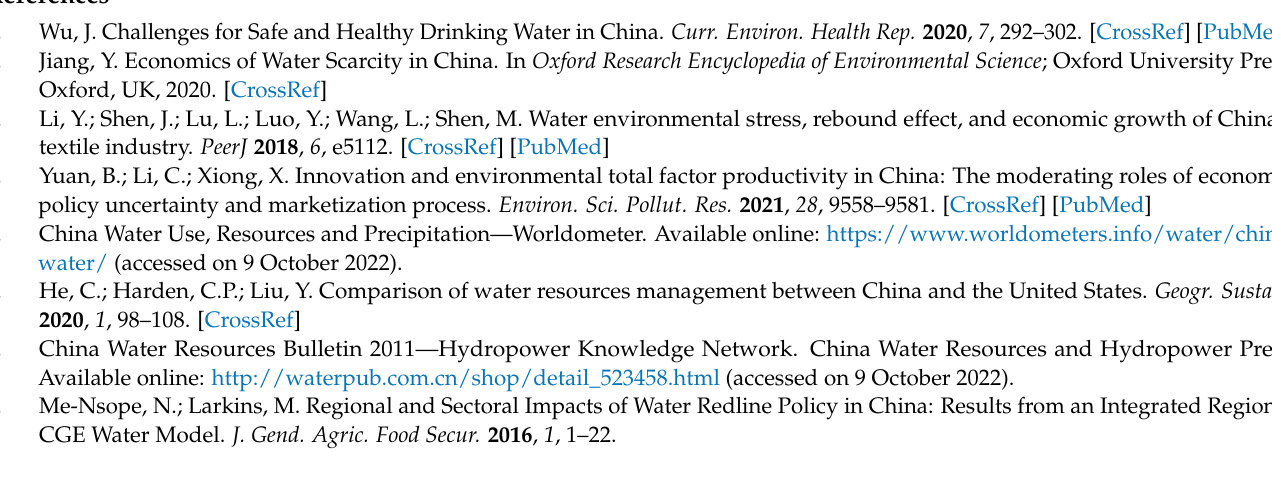
Figure A1. Average WUE across 31 Chinese provinces (2006–2020).